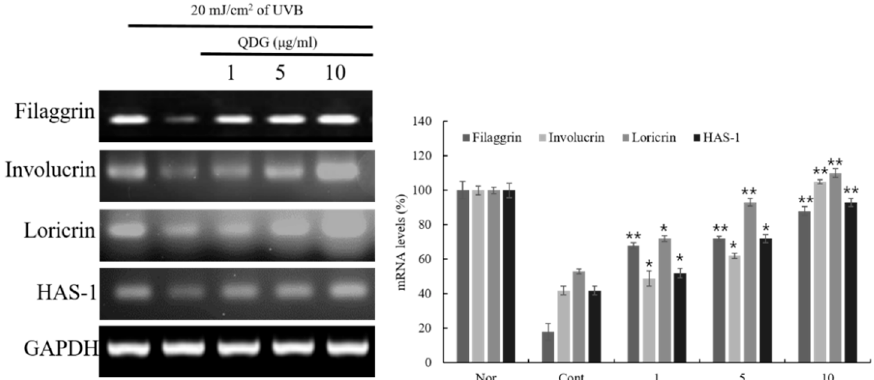
Figure 4. Effect of QDG treatment on skin barrier and hyaluronic acid synthase expressions in HaCaT cells. HaCaT cells were treated with different concentrations of QDG (1, 5, and 10 µ g/mL) after irradiation with 20 mJ/cm 2 UVB. After 6 h, cells were harvested and relative mRNA levels were determined. Histogram shows the densitometry for the skin barrier proteins and hyaluronic acid synthase mRNA normalized to glyceraldehyde 3-phosphate dehydrogenase (GAPDH). Each value represents mean ± SD for the three individual experiments. Nor: No treatment group (0 h), Cont: 20 mJ/cm 2 UVB treatment group, QDG: QDG treatment group. n = 3, * = p < 0.001 and ** = p < 0.0001 compared with the control group.